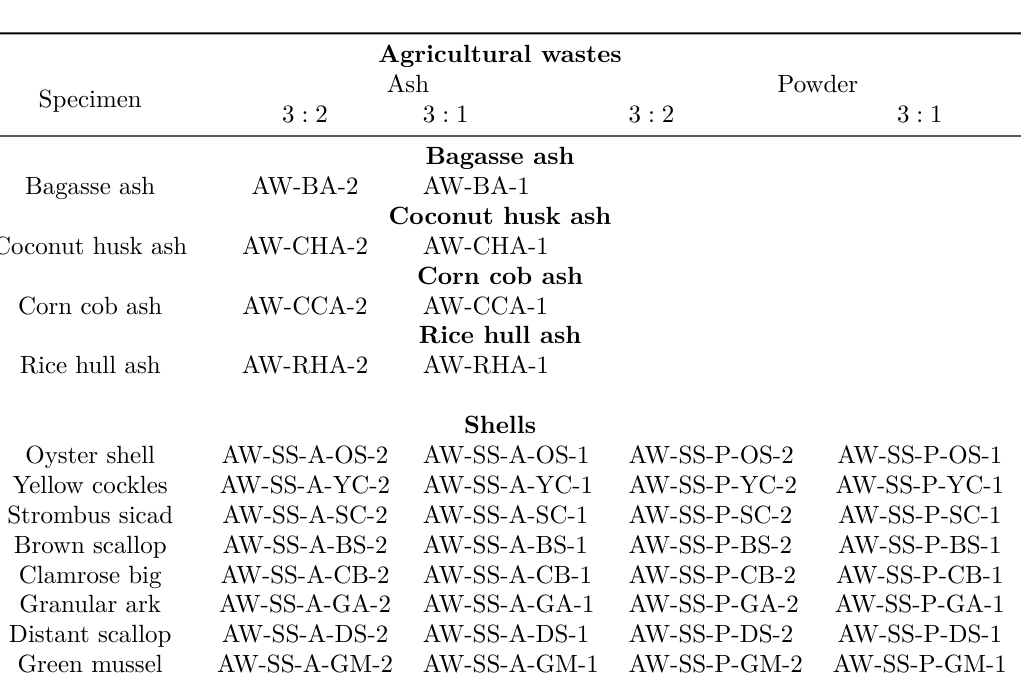
Table 1. Process of accumulation adapted from previous researches.